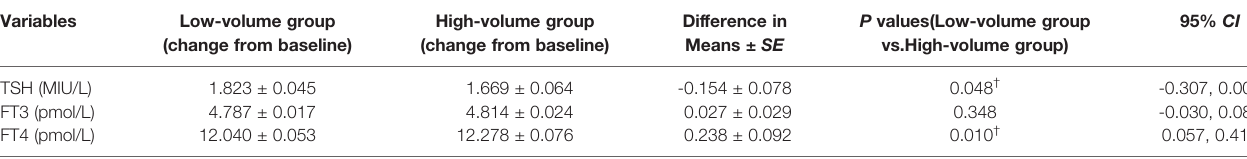
TABLE 2 | Comparison of thyroid function between the low-volume group and high-volume group at the 12th month. Variables Low-volume group (change from